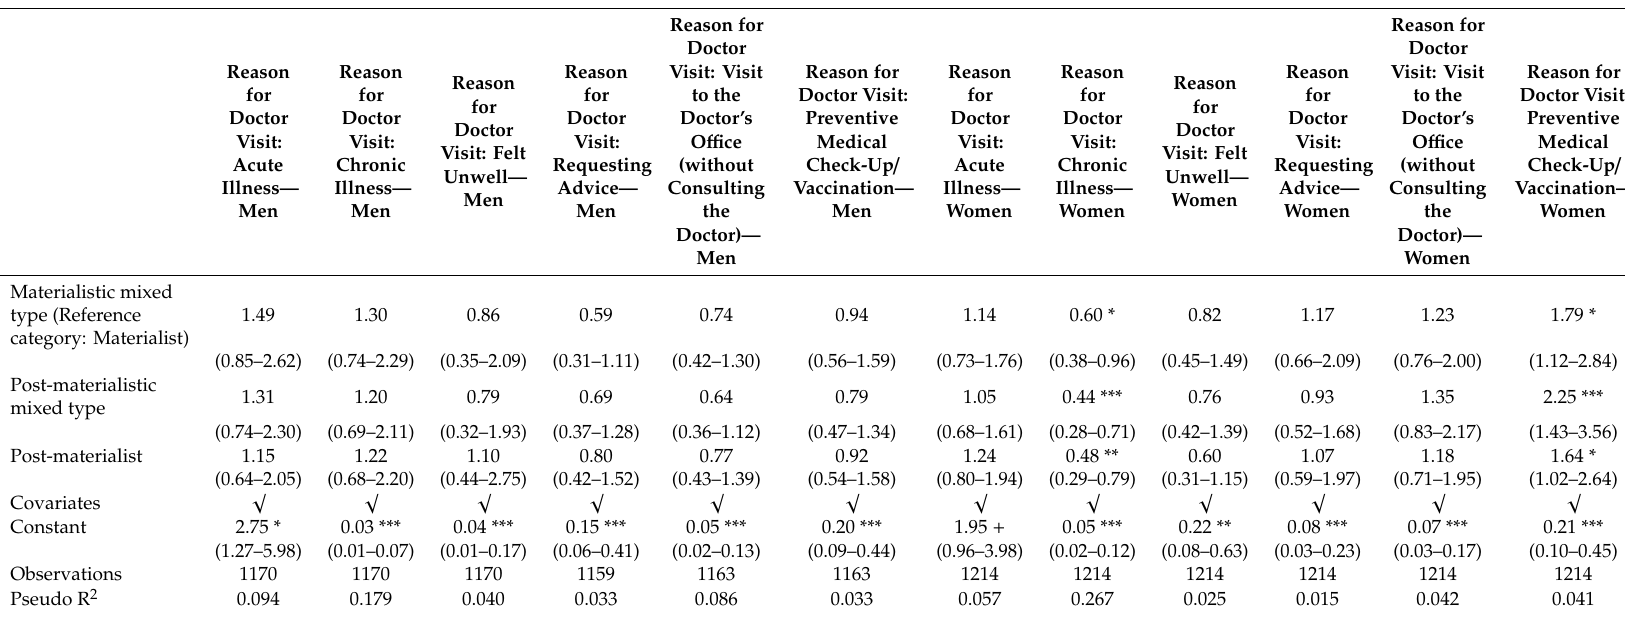
Table 3. Determinants of seeing the doctor (for several reasons). Results of logistic regressions (1 = yes, visiting the doctor for this reason; 0 =